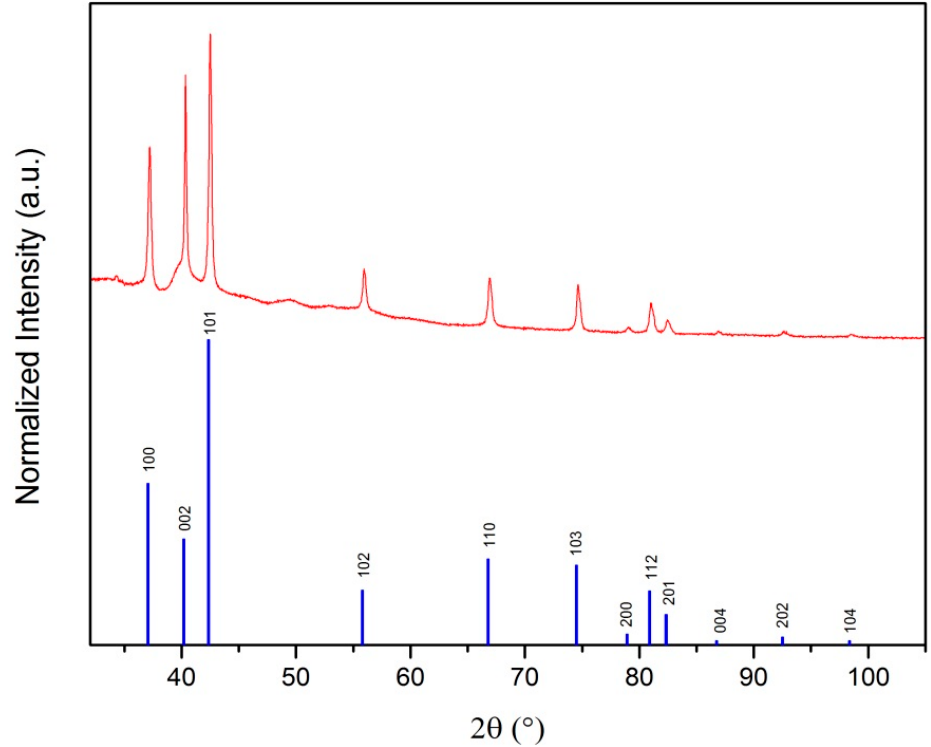
Figure 4. XRD pattern of the zinc-oxide-nanorod-coated cotton fabric.